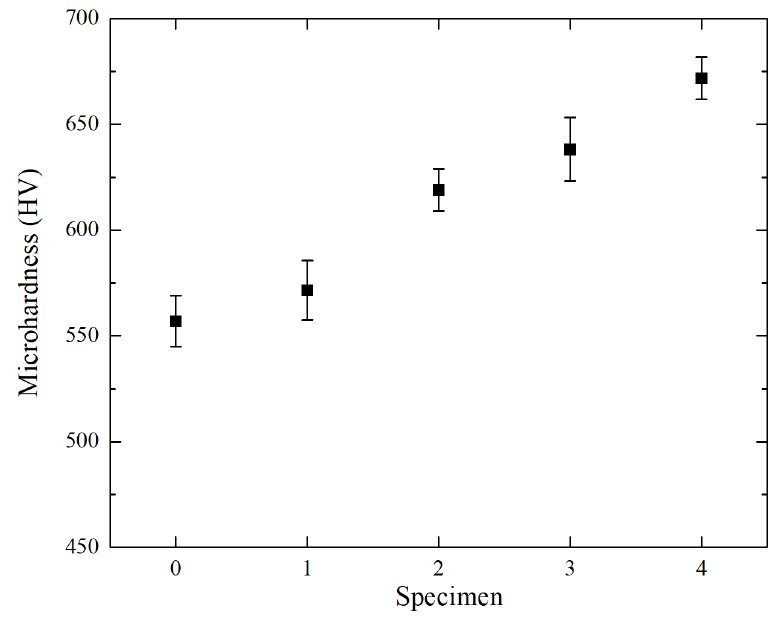
Figure 8. Microhardness of AM